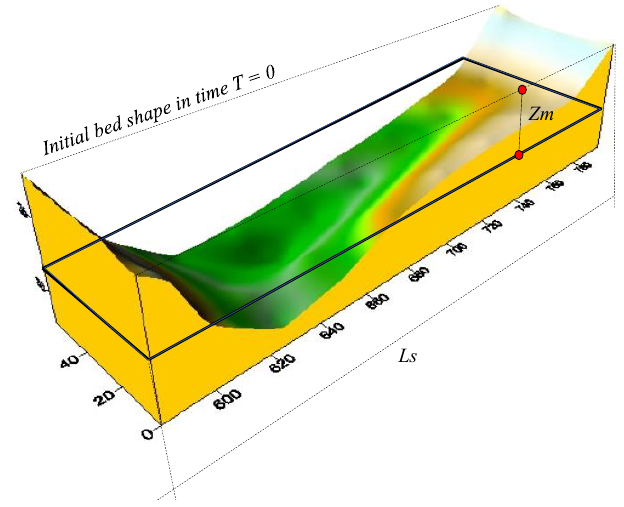
Figure 11 . Stabilized bed shape, downstream of the water structure, where: z m —medium scour depth; L s — local scour length.